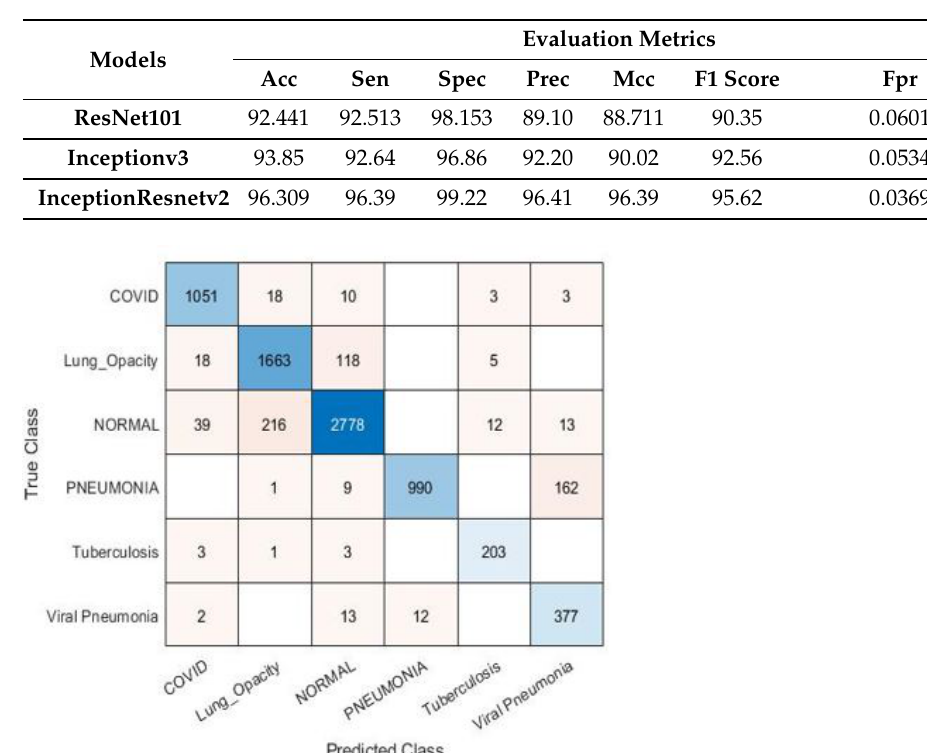
Table 7. Results for pre-trained models with image SR using dataset #2.